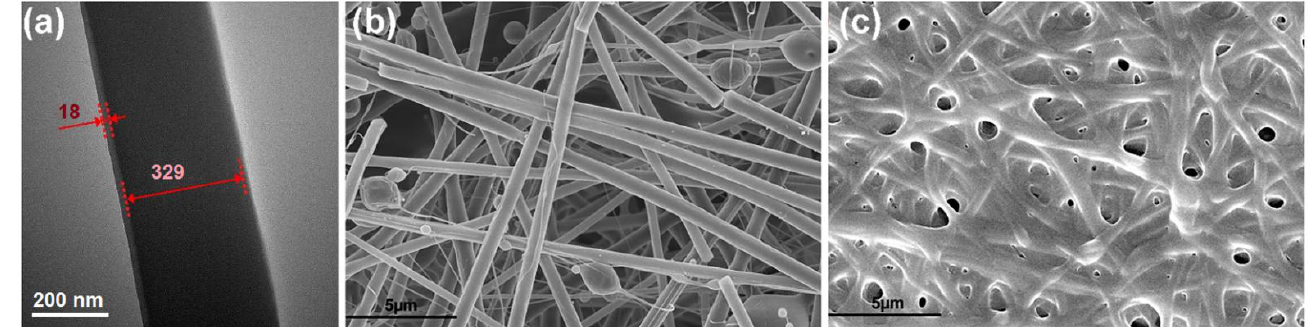
Figure 6. ( a ) The TEM micrographs of the core–sheath fiber membrane; the SEM micrographs of the fiber membrane after crosslinking: ( b ) only core–sheath fiber membrane F1; ( c ) hybrid fiber membrane F2.